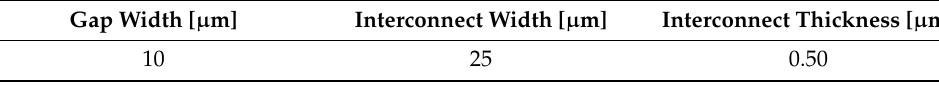
Table 1. Dimensions of the gold interconnect.